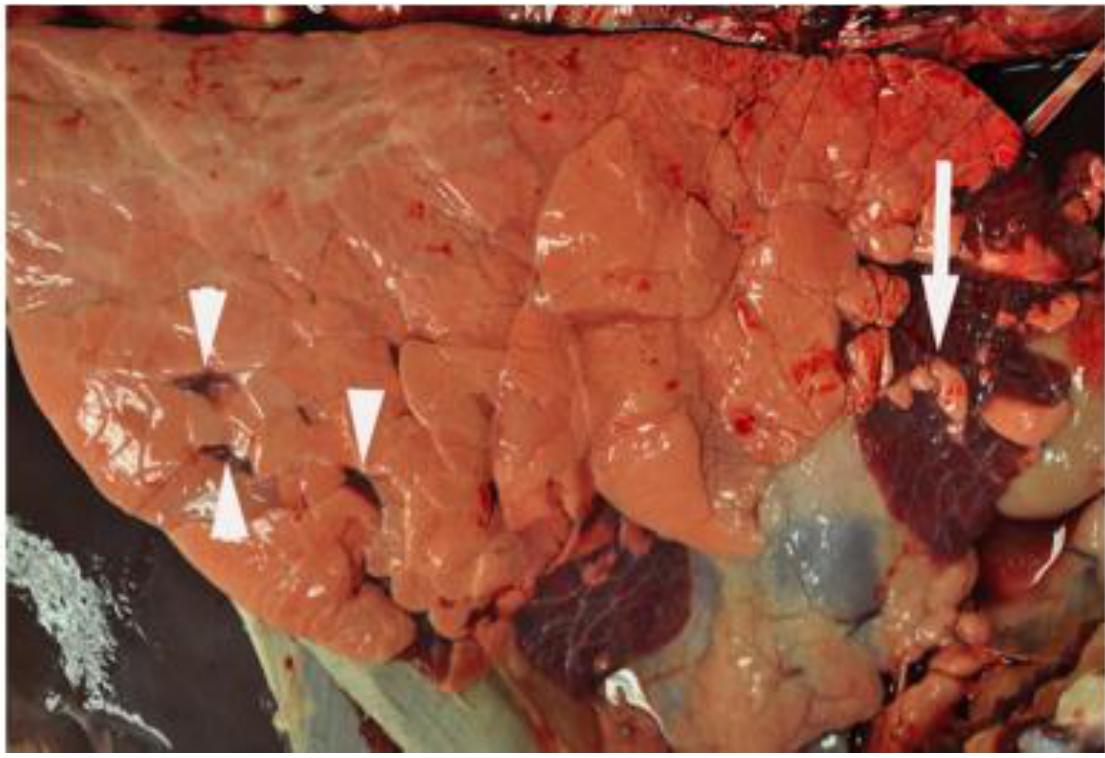
Figure 1. Lung from an RSV-infected calf at day 7 post-infection . Note multifocal to coalescing areas of plum-red consolidation in cranial and ventral aspects of right cranial and middle lobes. Consolidated areas surround and divide foci of pale pink hyperinflated lung (arrow). Scattered multifocal areas of consolidation are also present in the ventral third of the right caudal lobe (arrowheads). Original figure: